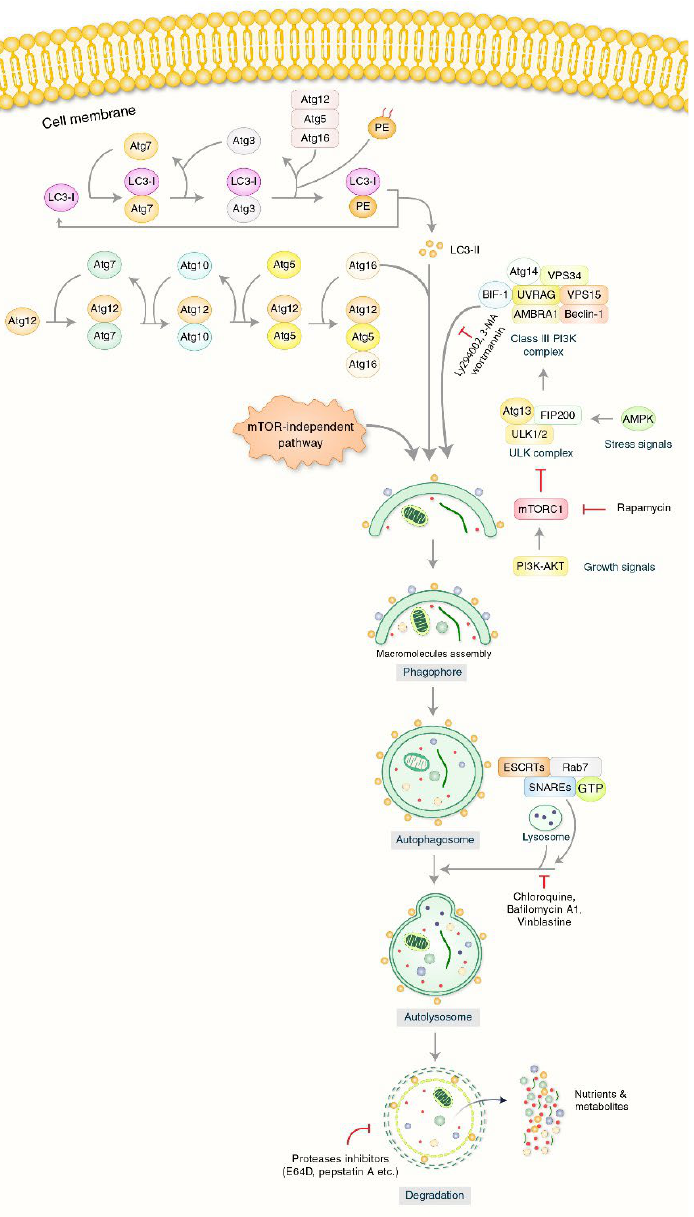
Figure 2. Molecular mechanism of autophagy. Autophagy process is initiated through the formation of the phagophore structure formation. PI3K-AKT and mTOR have been predisposed to form phagophore initiation. Beclin-1, UVRAG, and VPS34 complexes help to initiate phagophore formation. Phagophore nucleation has been extended to autophagosome formation. Binding between mature autophagosomes as well as lysosomes indicates the autolysosome formation. Chloroquine (CQ), Bafilomycin A1 (BAF-A1), and Vinblastine inhibit the binding of lysosomes and autophagosomes. Eventually, autolysosomes will be eliminated by acid hydrolases that produce nutrients as well as recycling